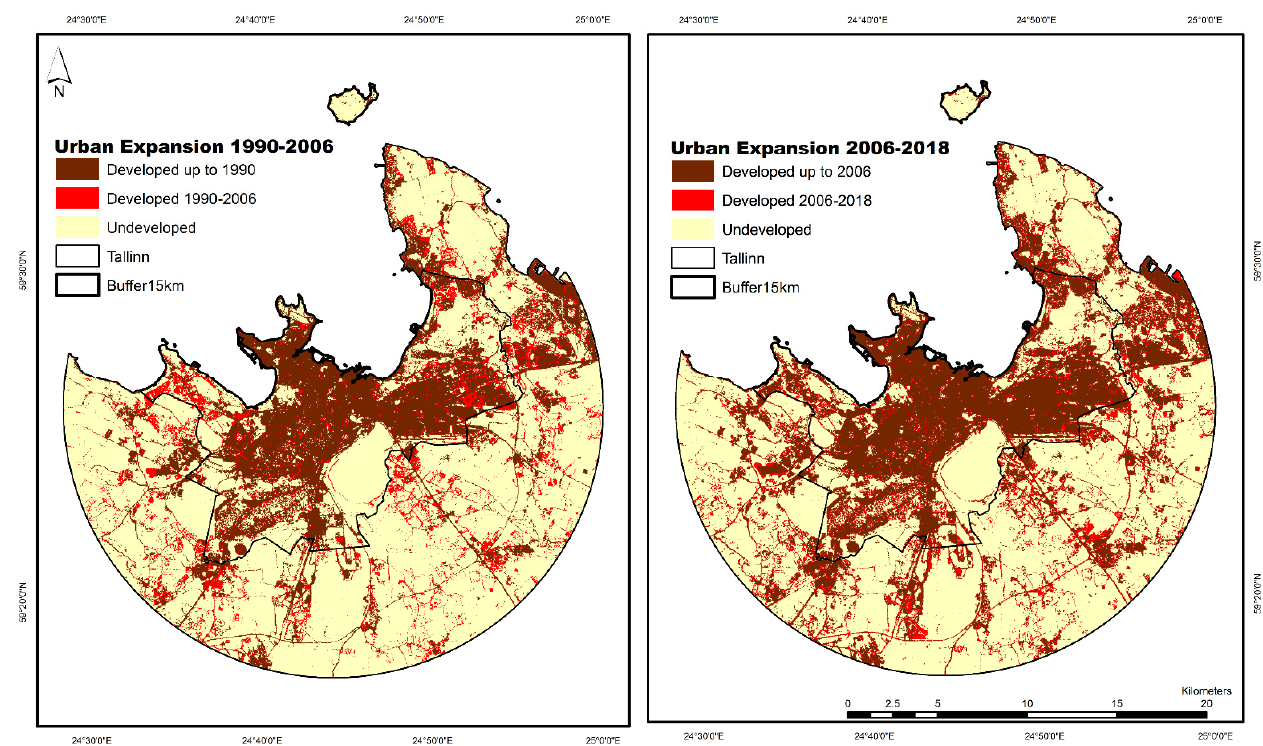
Figure 4. Urban expansion between 1990–2006 and 2006–2018, which represents the state of the agents.